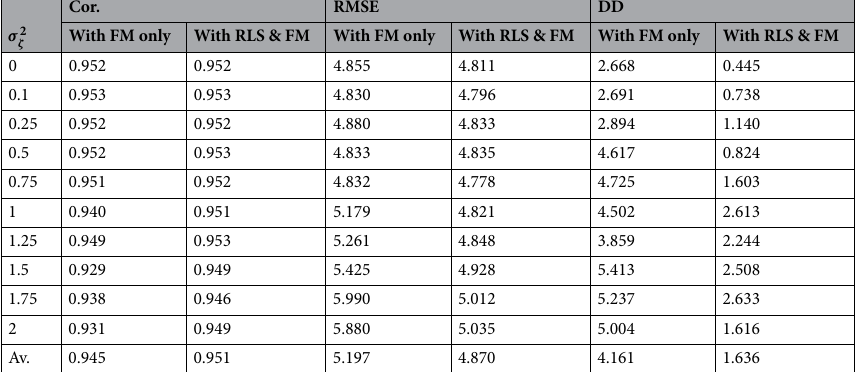
Table 4. RMSE, Correlation (Cor.) and Depth Distortion (DD) in % for shape reconstruction using FM:SML with different levels of variance of Jitter noise ( σ 2 ξ = ( 2 ak + b ) 2 σ 2 ζ + 2 a 2 σ 4 ζ ), with and without proposed RLS filter.